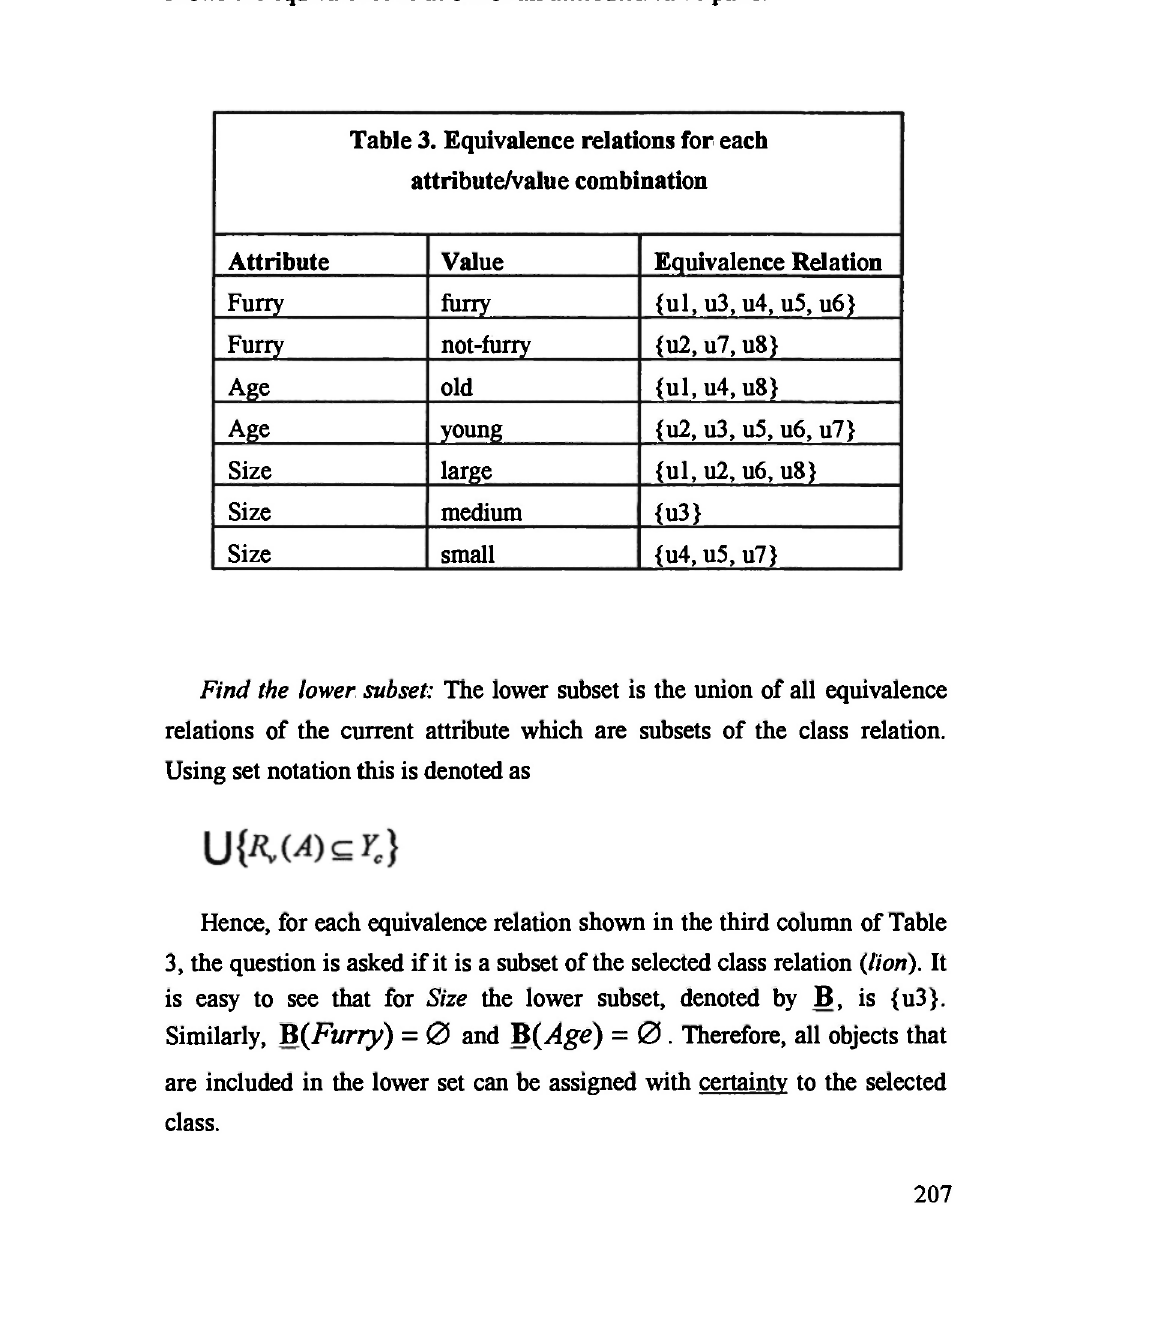
Table 3. Equivalence relations for